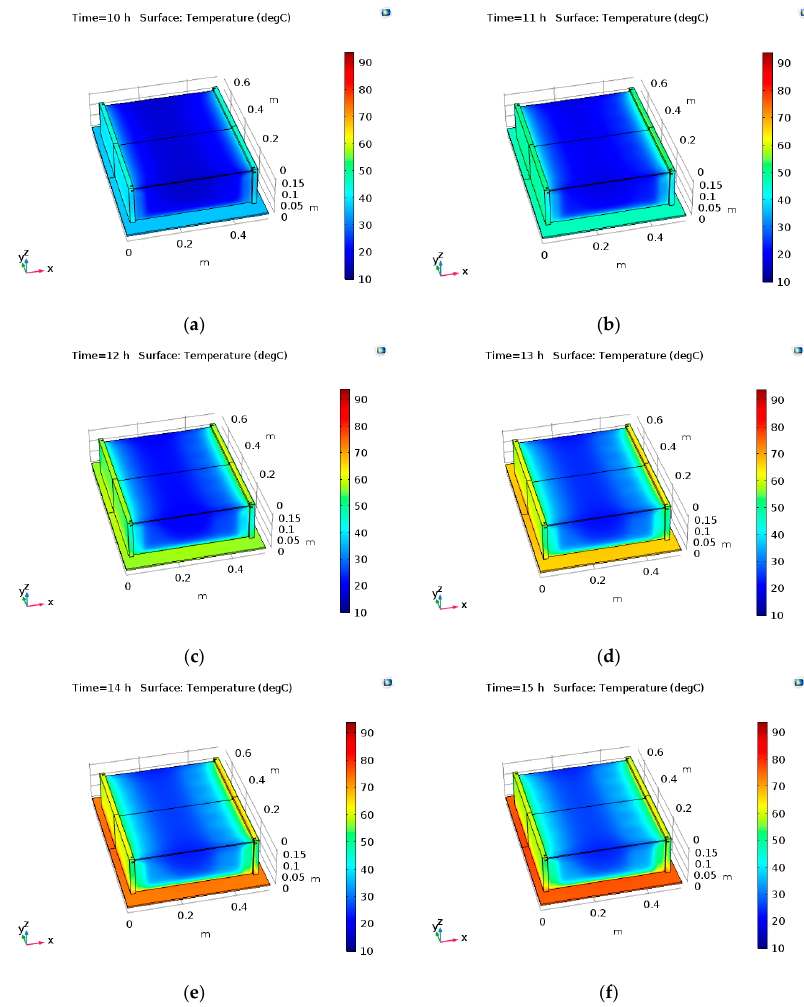
Figure A1. Temperature field on the whole surfaces of the assembly for the covered CPC scenario (17 July 2017) at the following times: ( a ) 10:00; ( b ) 11:00; ( c ) 12:00; ( d ) 13:00; ( e ) 14:00; ( f ) 15:00.